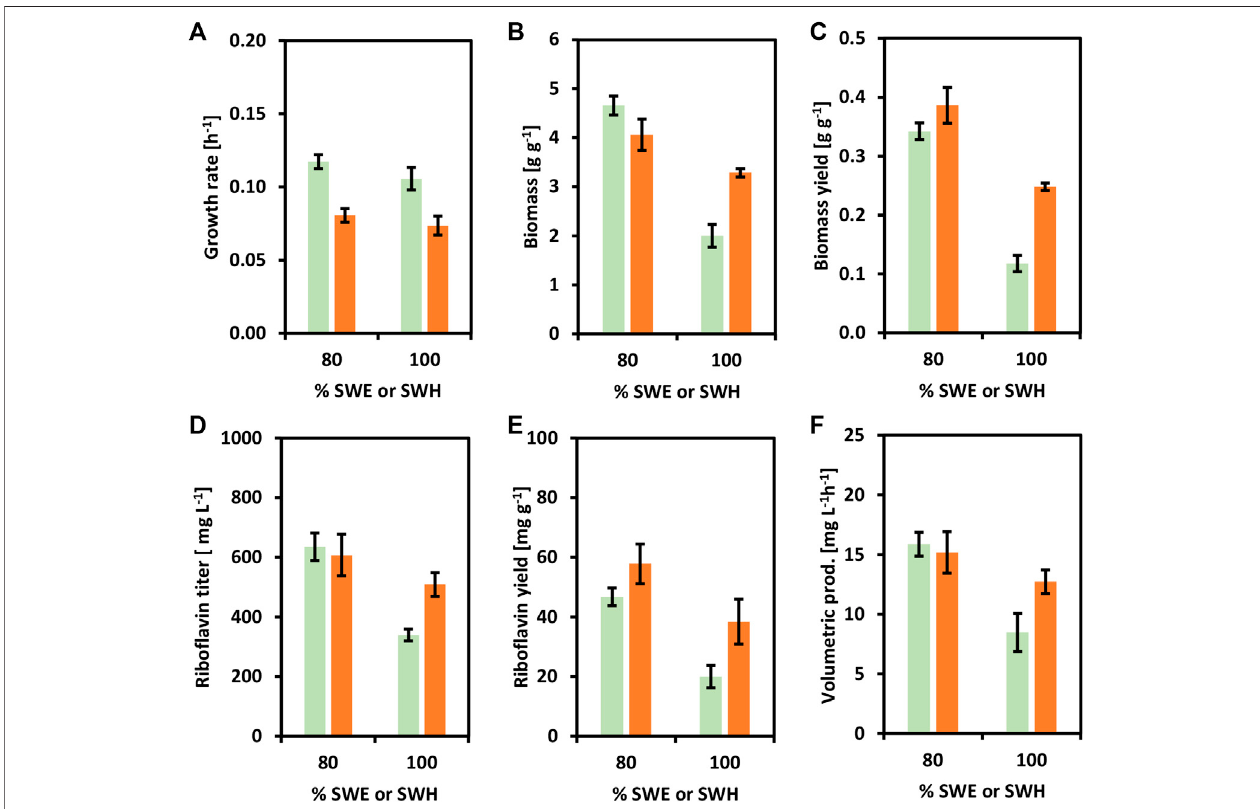
FIGURE7| Growthandribo fl avinproduction frombrownseaweed-based substrates ofthestrainCgRibo4.SWE(green columns) orSWH(orangecolumns) were assayedintheconcentrationsof80and100%. (A) Growthrates(h − 1 )ofCgRibo4. (B) Finalbiomassesofformed(gL − 1 )CgRibo4. (C) Biomassyields(gg − 1 )ofCgRibo4. (D) Final ribo fl avin titers (mg L − 1 ) of CgRibo4. (E) Ribo fl avin yields (mg g − 1 ) of CgRibo4. (F) Ribo fl avin volumetric productivities (mg L − 1 h − 1 ) of CgRibo4. Means and standard deviations of triplicates are